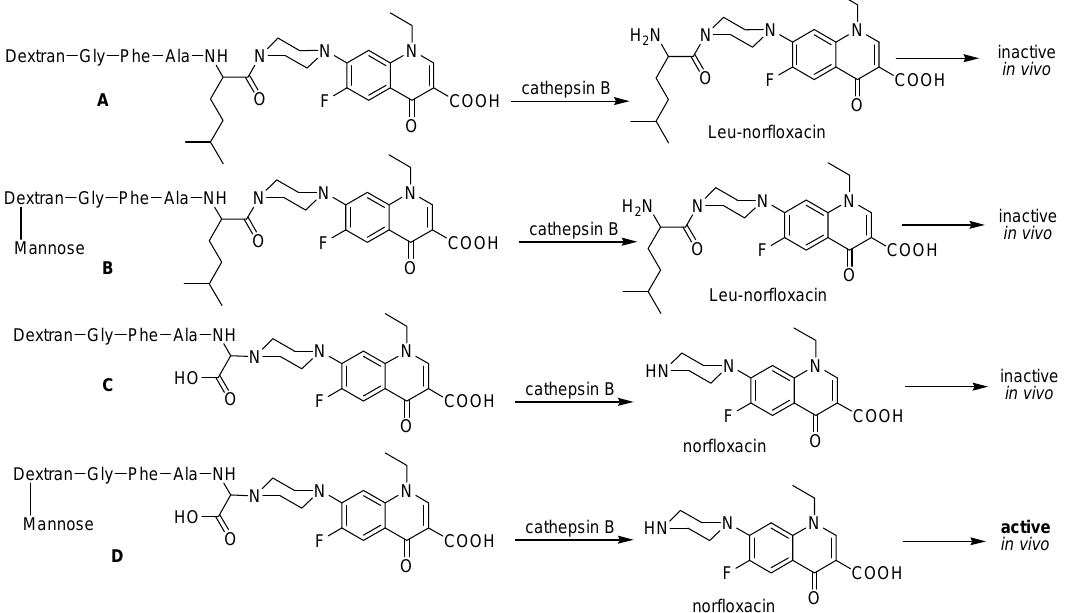
Figure 40. Schematic representation of the polymeric prodrugs and the product of enzymatic hydrolysis activity. A and B, norfloxacin linked through amide bond and C and D, norfloxacin linked through an α